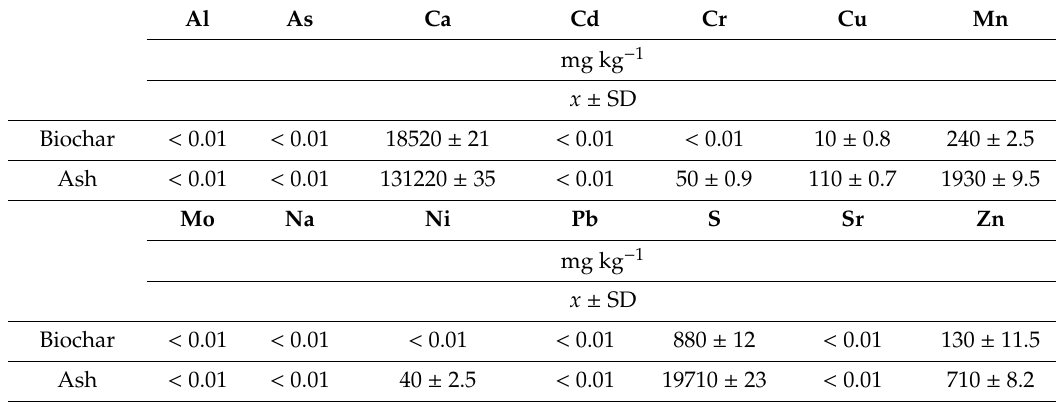
Table 5. Contents of selected macro- and micro-elements in the biochar and biomass ash. Al As Ca